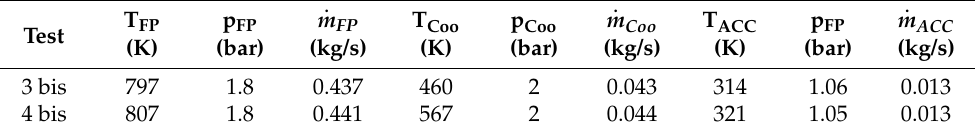
Table 11. Experimental inlet conditions for the rhomboidal cells.